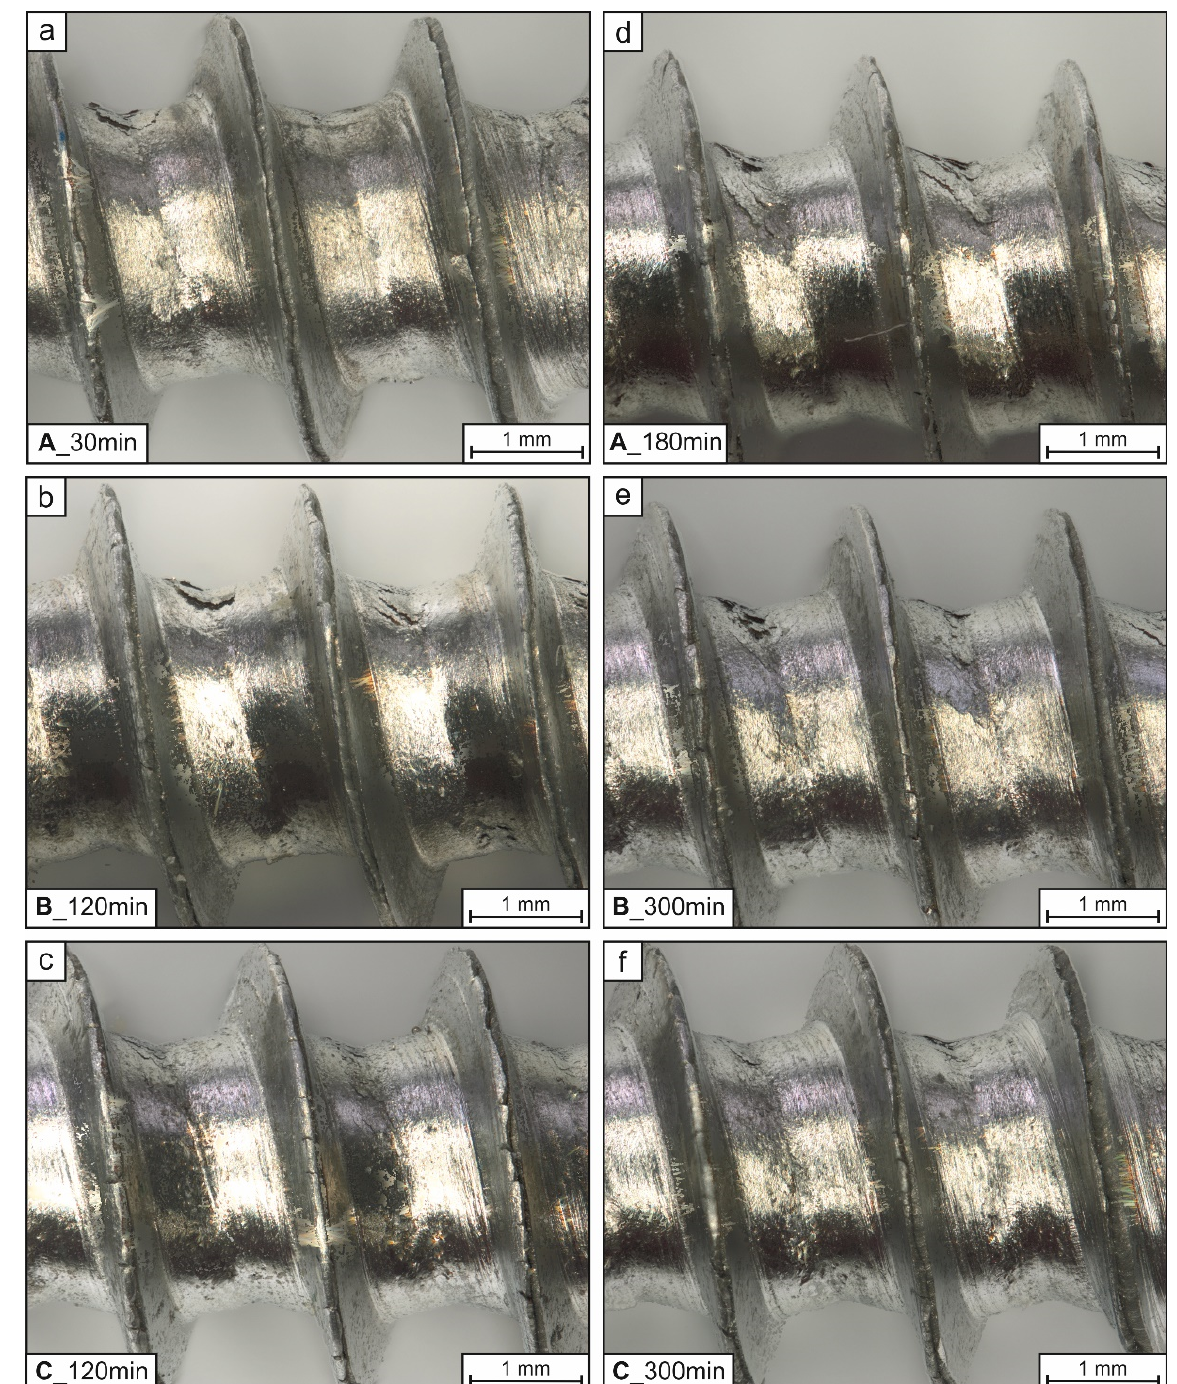
Figure 7. Stereo micrographs of the different processed and thread rolled parts. Processing route and initial heat treatment: ( a , b ) processing route A (initially solution-annealed), ( c , d ) processing route B (initially naturally aged), ( e , f ) processing route C (initially pre-aged). Artificial aging time: ( a – c ) local hardness maximum and ( d – f ) global peak-hardness achieved. Independent of the processing route, for all threaded parts, the threads are not fully formed and the closing fold near the top of the teeth is still open.